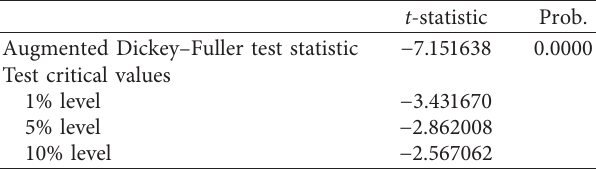
Table 5: Unit root test of sequence bs for IH dominant contract.